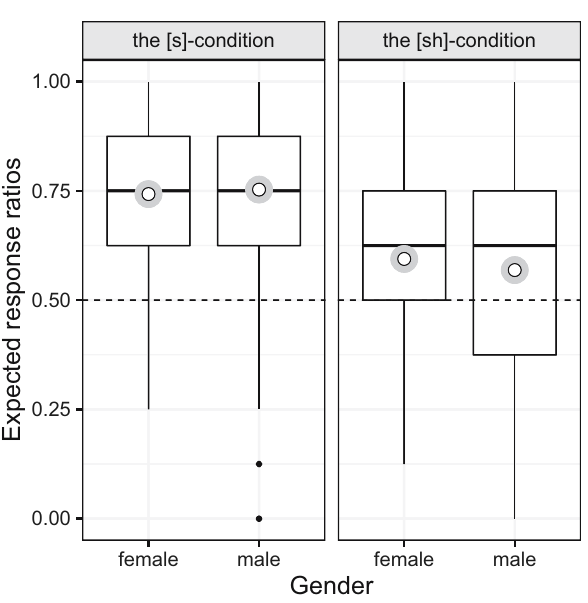
Figure 5: The e ff ects of gender on expected response ratios in the large data set.